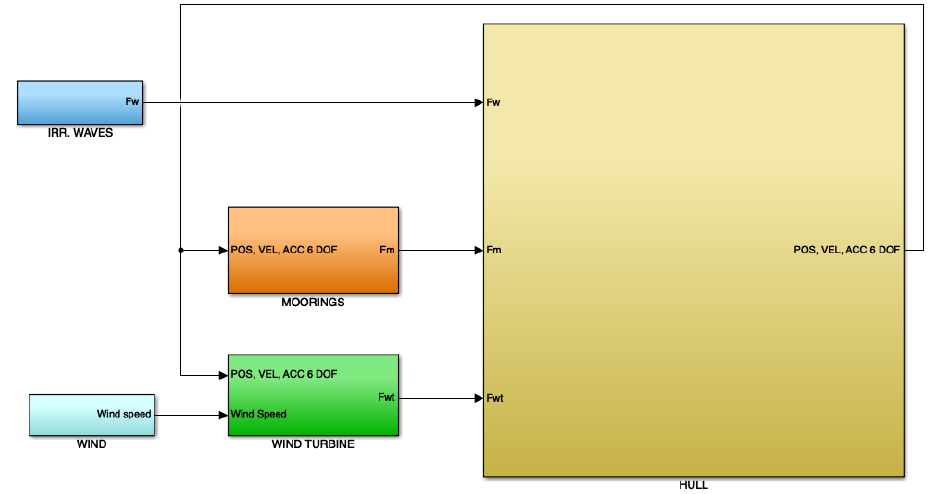
Figure 2. Relations between the Simulink model